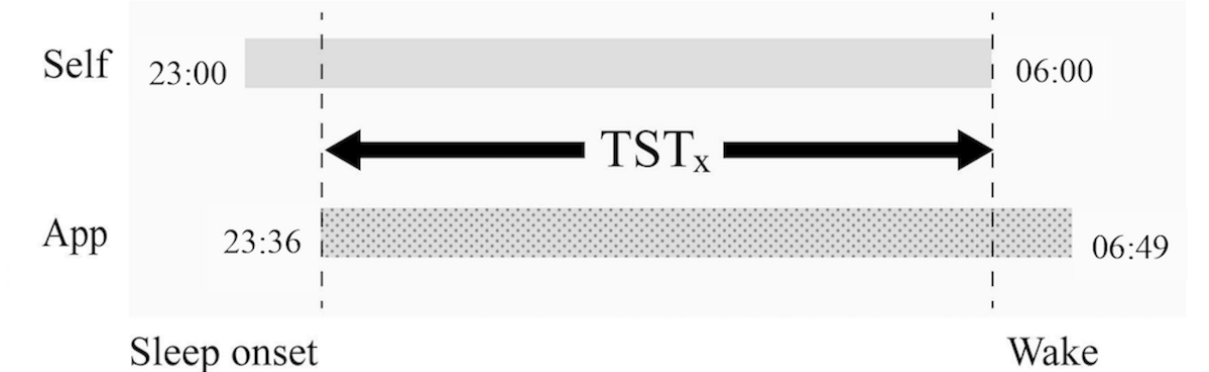
Figure 2. Definition of sleep onset time, midpoint of sleep, and wake time. TST: total sleep